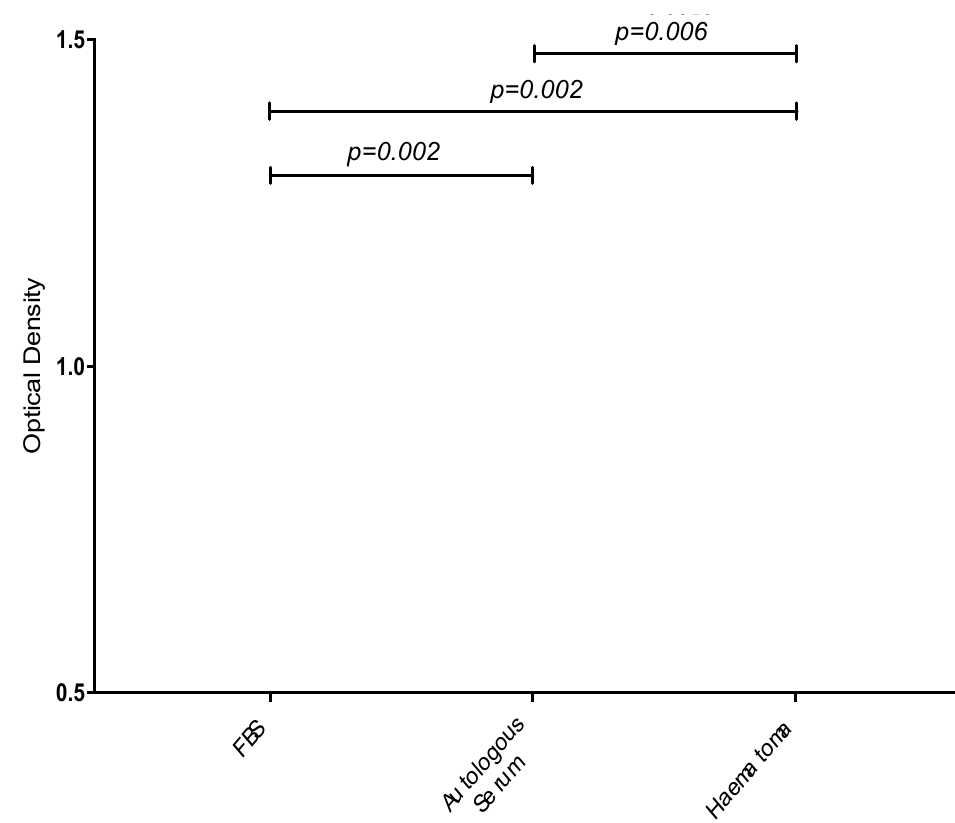
Figure 4. Box plots demonstrating the measured optical densities from the calcium colorimetric assay. Comparisons of calcium deposition between cells cultured in 10% FBS supplementation, 10% autologous serum and 10% fracture haematoma.